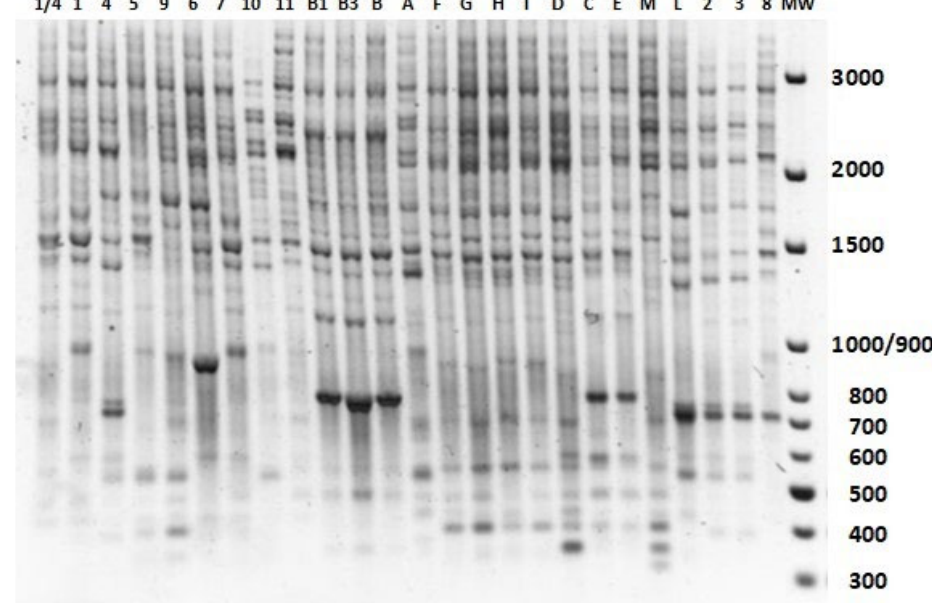
Figure 5. IRAP fingerprints obtained with a primer (ANG5+) targeting LTR-REs belonging to the Copia / Angela lineage in 25 accessions of S. rebaudiana . Genotype codes are listed in Table 3 (see Methods). A molecular weight marker (MW, 100 bp DNA Ladder (Solis Biodyne)) was loaded. The fragment size (bp) is indicated to the right.